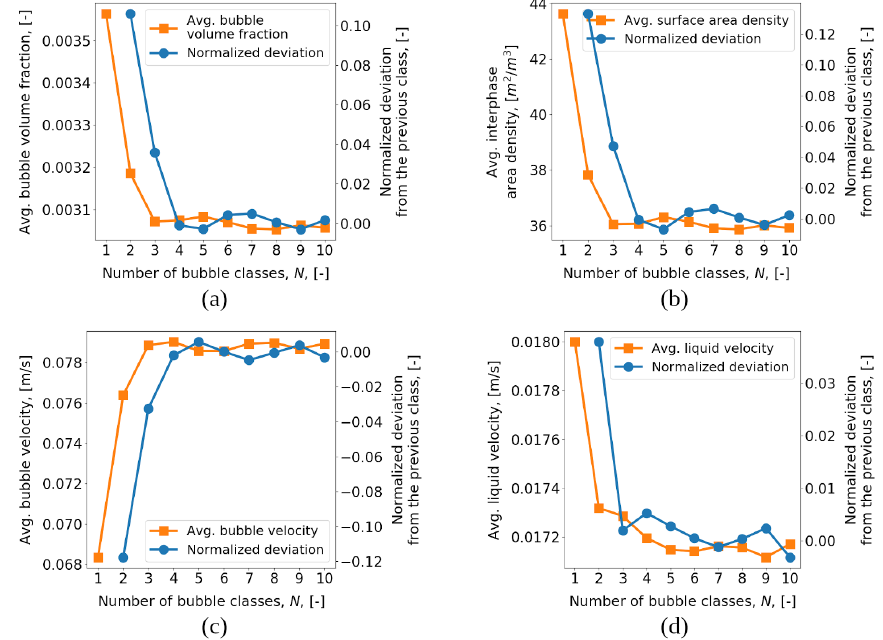
Figure 3. Distributions of flow parameters as a function of the number of bubble classes. The characteristic bubble size d b = 0.25 mm; ( a ) the bubble volume fraction; ( b ) the interfacial area density; ( c ) the bubble velocity; ( d ) the liquid